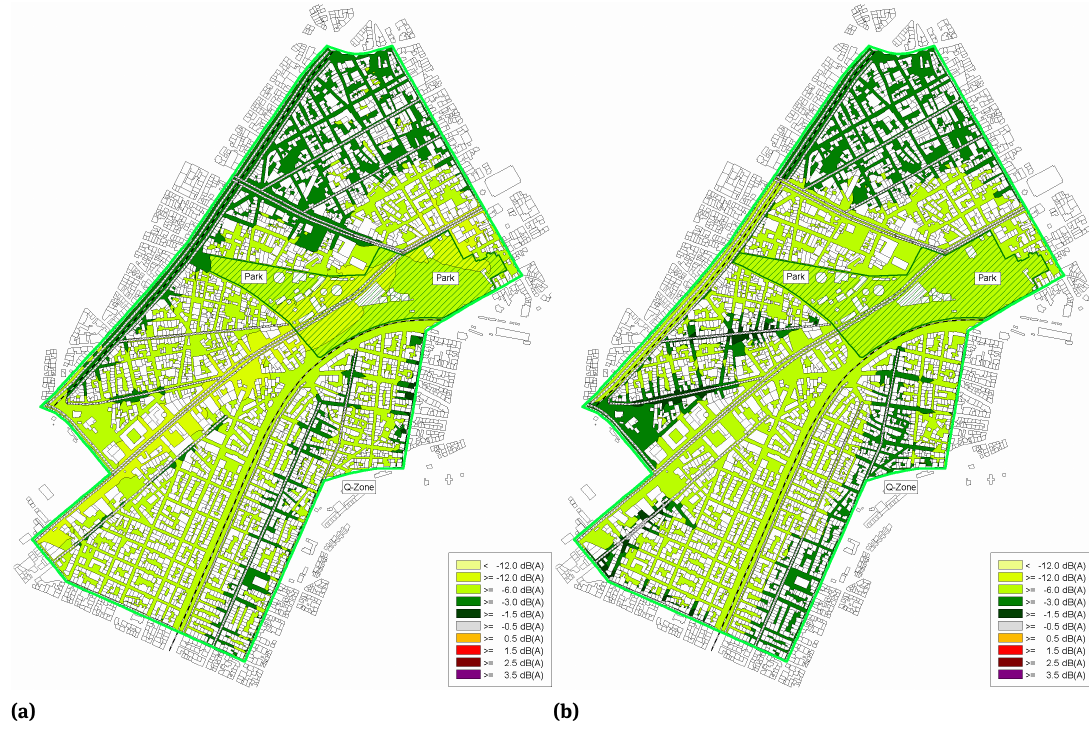
Figure 16: Difference Scenarios S05-S01 - L